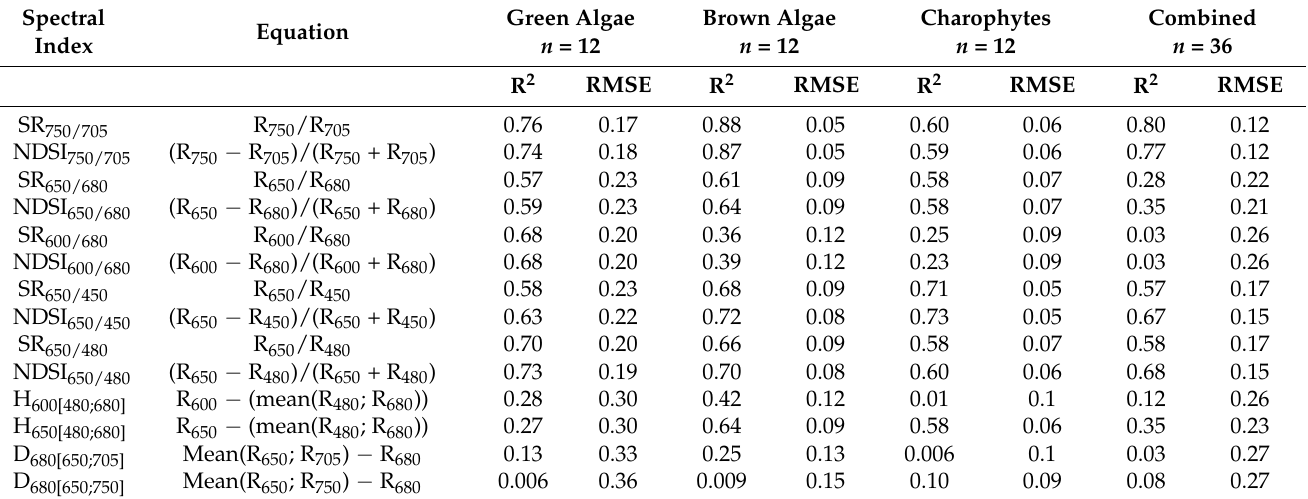
Table 2. The coefficient of determination (R 2 ) and root mean square error (RMSE) between chlorophyll concentration (mg/g wet weight Chla a+b) and spectral indices for the WW dataset. R 2 and RMSE are given separately for each vegetation class and for combined